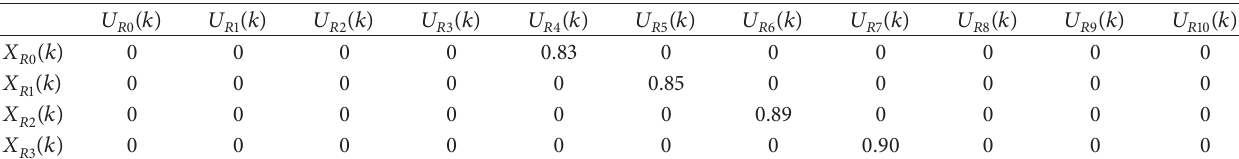
of the sensitivity of unconscious reaction. OM